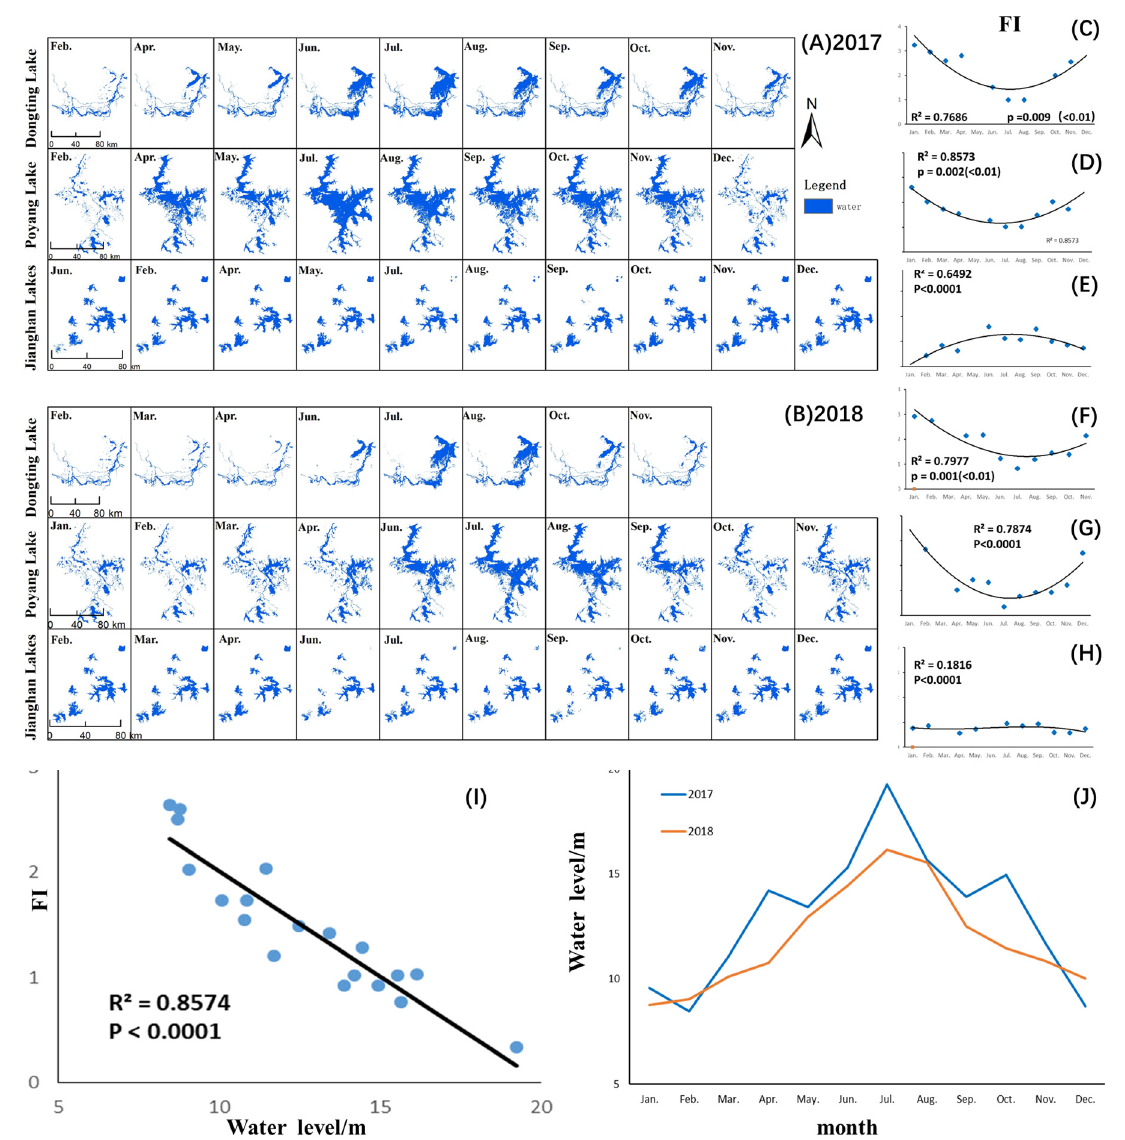
Figure 3. Water surface distribution of DT, PY, and JH extracted from remote sensing images in ( A ) 2017 and ( B ) 2018. The trend of PD in ( C ) PY, ( D ) DT, and ( E ) JH in 2017. The trend of PD in ( F ) PY, ( G ) DT, and ( H ) Jianghan Lakes in 2018. ( I ) shows the relationship between PD index and water level data from Xingzi Station in Poyang Lake. ( J ) shows the monthly average water level at the Poyang Lake Xingzi Station in 2017 and 2018.